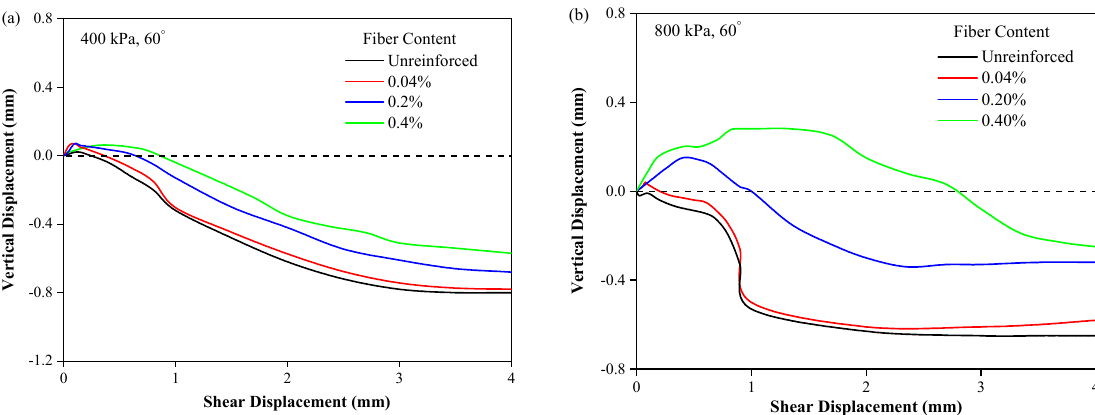
Figure 6. Vertical displacement of sand specimens with fibers initially orientated at 60° under normal pressures of ( a ) 400 and ( b ) 800 kPa.